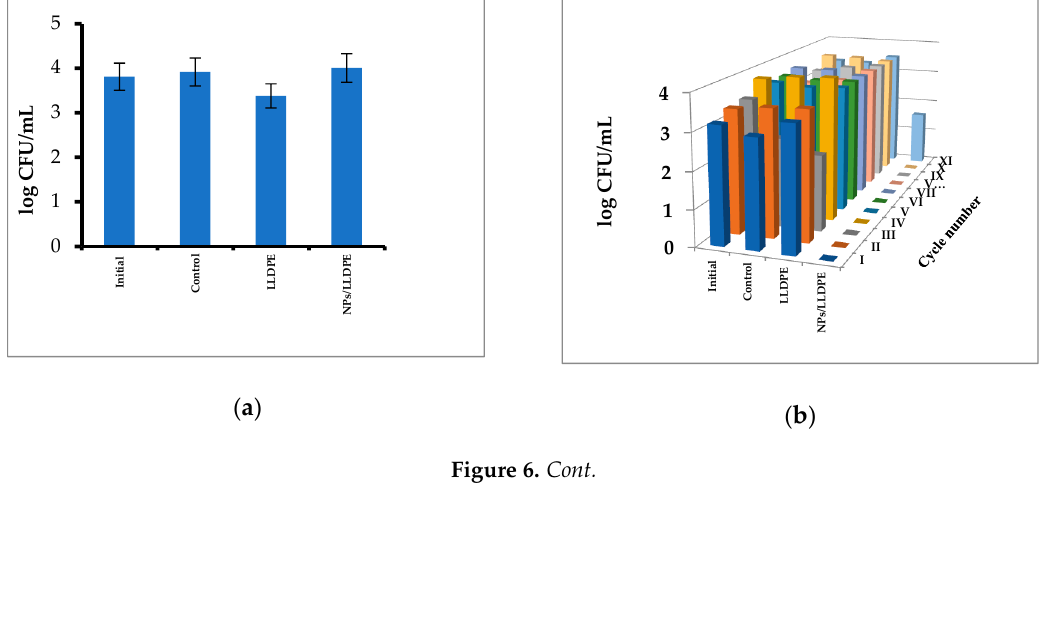
Figure 5. Activity of free Cu 2 ONPs against ( a ) Staphylococcus aureus and ( b ) Escherichia coli cells. Control—untreated bacterial cells.